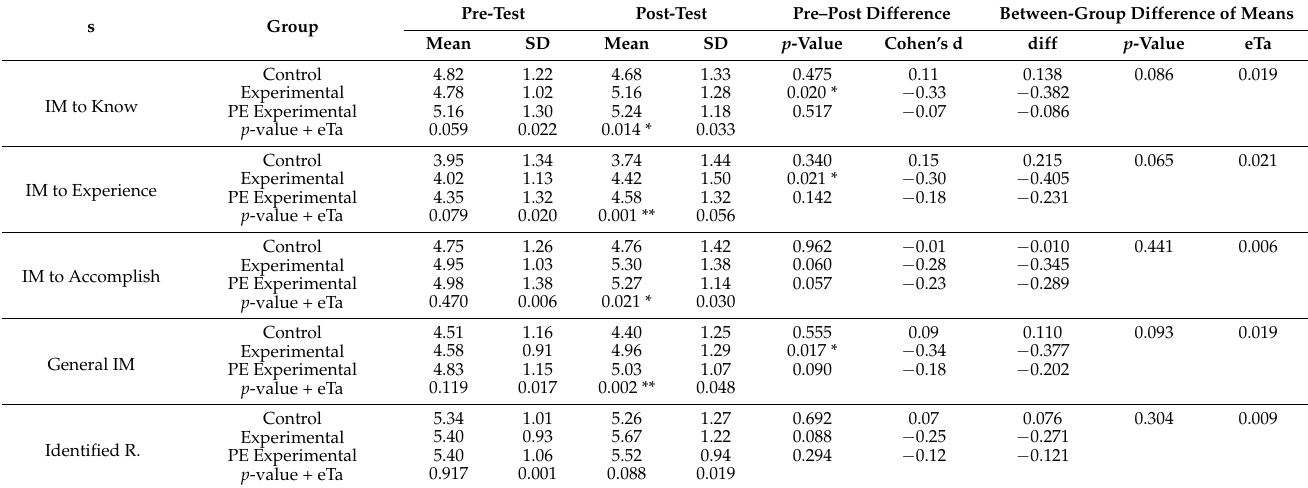
Table 3. Self-determination theory results